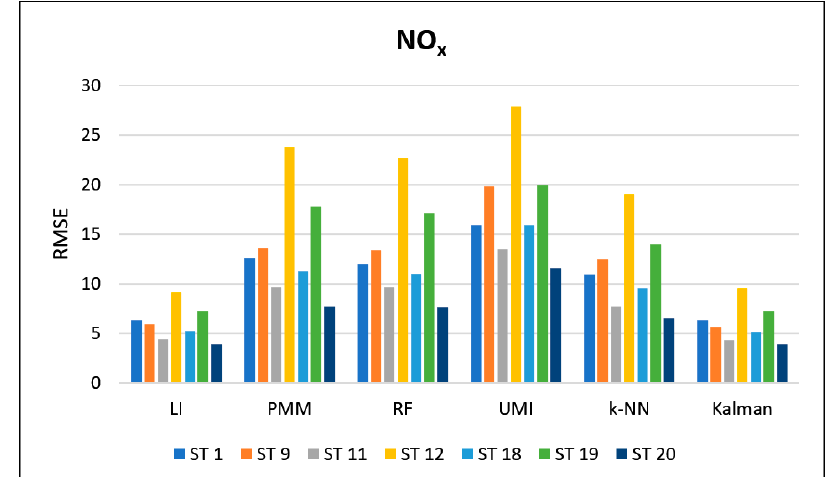
Figure 8. RMSE error for NO X .